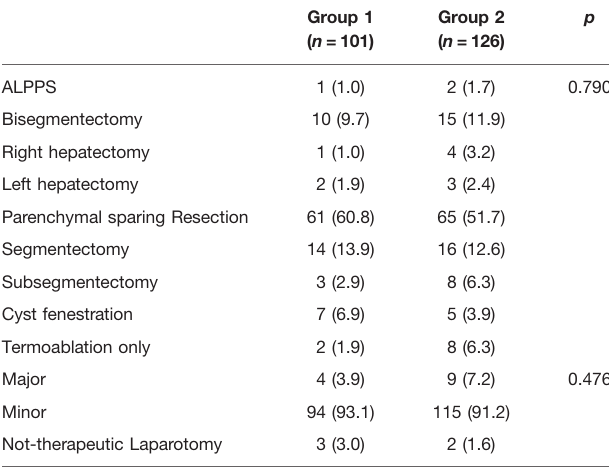
TABLE 3 | Type of surgery and extension of liver resection.